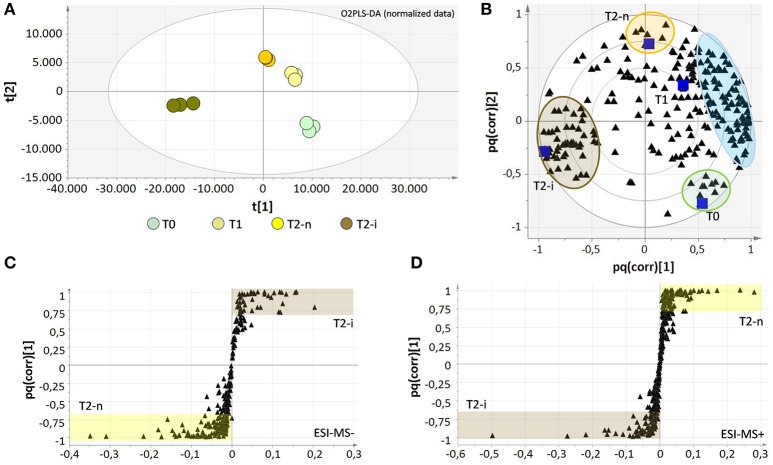
Score plots (A) and correlation loading plots (B) for the O2PLS-DA model of the negative data matrices after data normalization for sample weight loss. The metabolites which strongly characterize each sample are highlighted with colored circles and are listed in Supplementary File 2 (Datasheet 1). The light blue circle comprises all metabolites that characterize the natural withering process and negatively correlate with berries infected with noble rot (T2-i). Correlation loading plots for the OPLS-DA models of negative (C) and positive (D) data matrices show the distribution of metabolites between T2-n and T2-i berries. All metabolites with pq(corr) values > 0.7 or < −0.7 are considered highly characteristic of T2-n (highlighted in yellow) or T2-i (highlighted in brown) berries and are listed in the Supplementary File 2 (Datasheet 2).